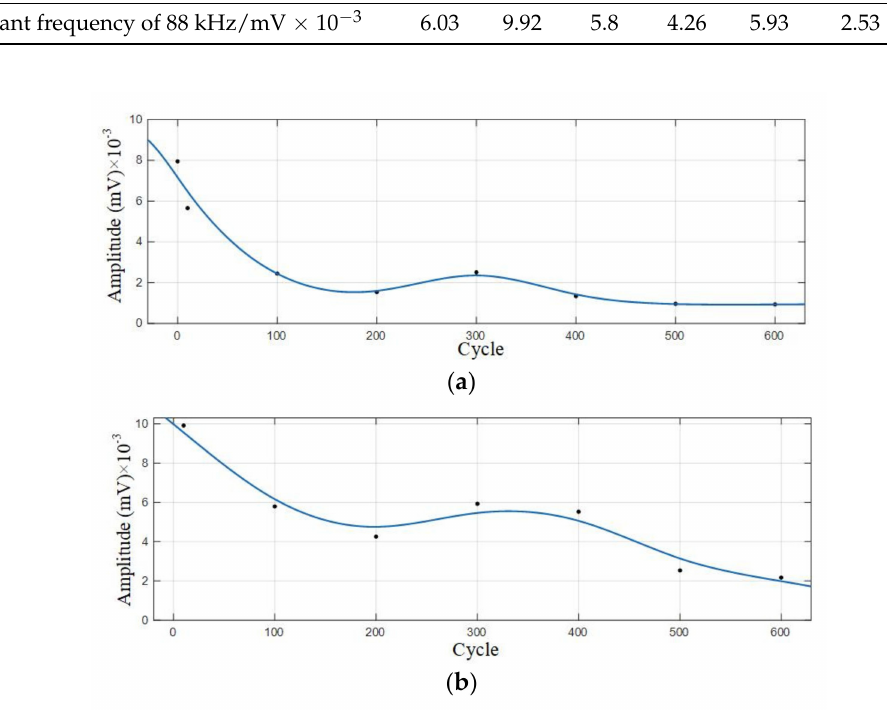
Figure 11. Amplitude variation curve of the 0–600 cycles of Group B batteries. ( a ) Amplitude variation curve with a dominant frequency of 60 kHz; ( b ) Amplitude variation curve with a dominant frequency of 88